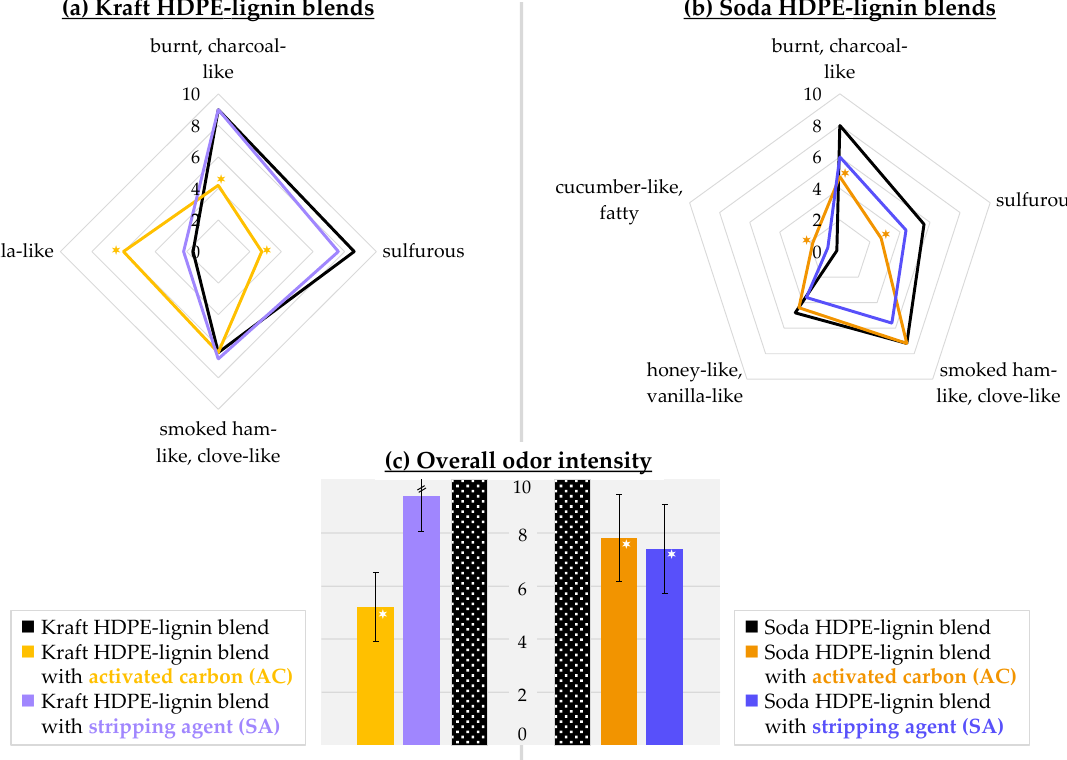
Figure 1. Odor profiles of ( a ) the kraft HDPE-lignin blends and ( b ) the soda HDPE-lignin blends ( n = 5; scale from 0 (no perception)–10 (strong perception)). ( c ) The overall odor of the kraft and soda blends treated with activated carbon or stripping agent (scale from 0 (no perception)–10 (overall odor of the respective untreated blend)). * significant differences are marked ( α =